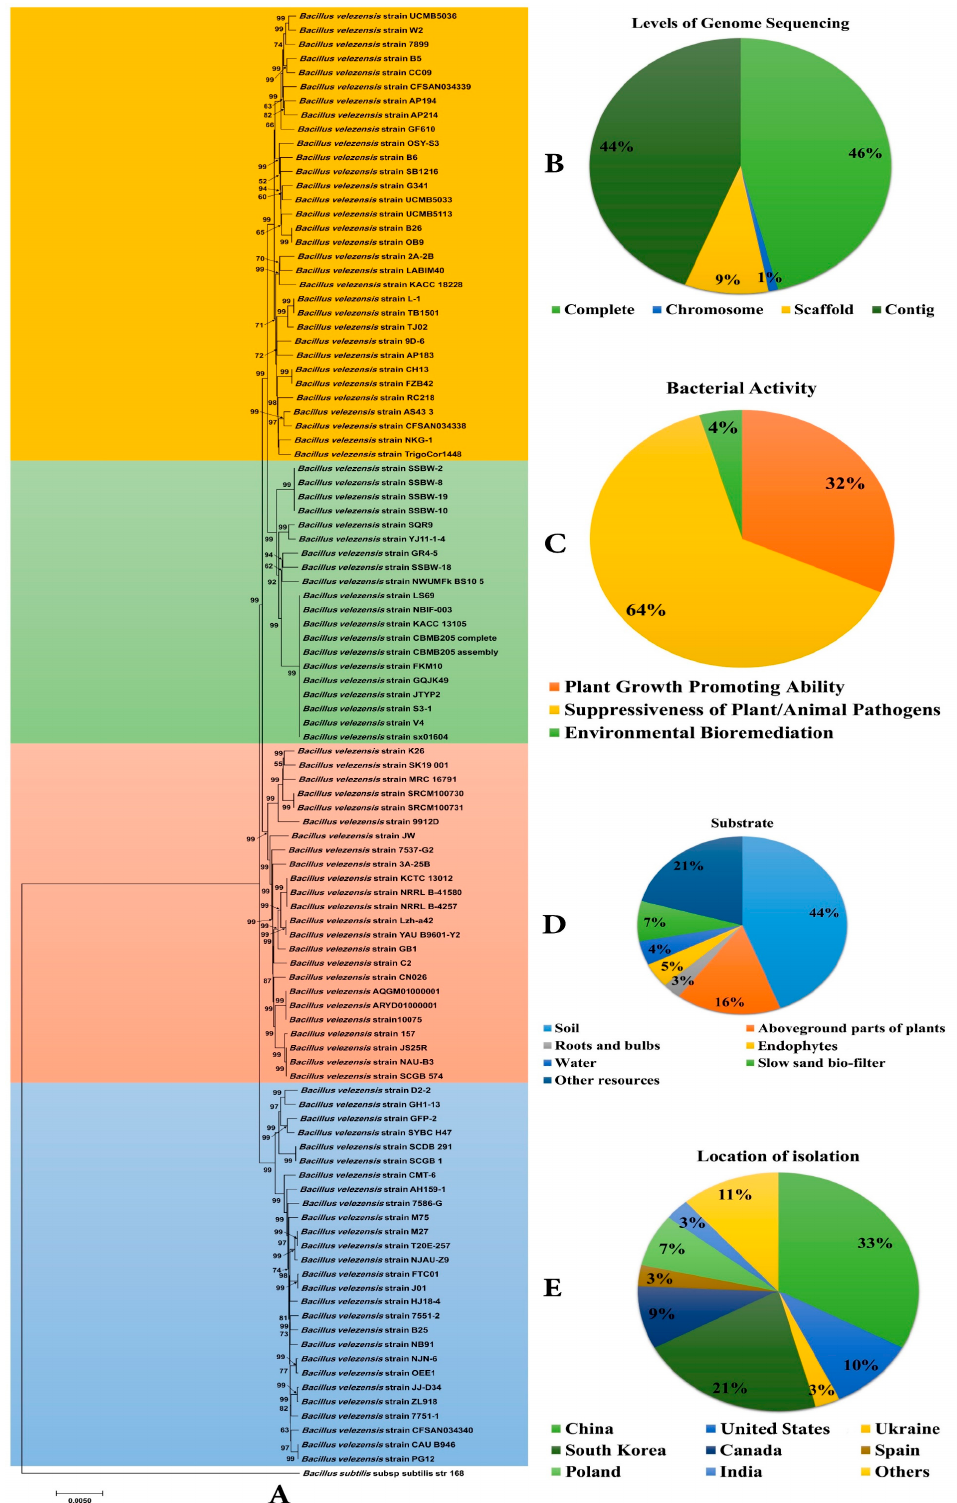
Figure 1. ( A ) Neighbor-joining phylogenomic tree of Gram-positive bacteria Bacillus velezensis isolates. Bacillus subtilis subsp. subtilis isolate 168 was used as outgroup. Supports for branches were assessed by bootstrap resampling of the dataset with 1000 replications. Each color corresponds to a “sister clade” that represent a putative new species, Percentages of ( B ) Levels of genome sequencing, ( C ) Bacterial activity, ( D ) Substrates, ( E ) Locations of isolation of biocontrol bacteria Bacillus velezensis strains.